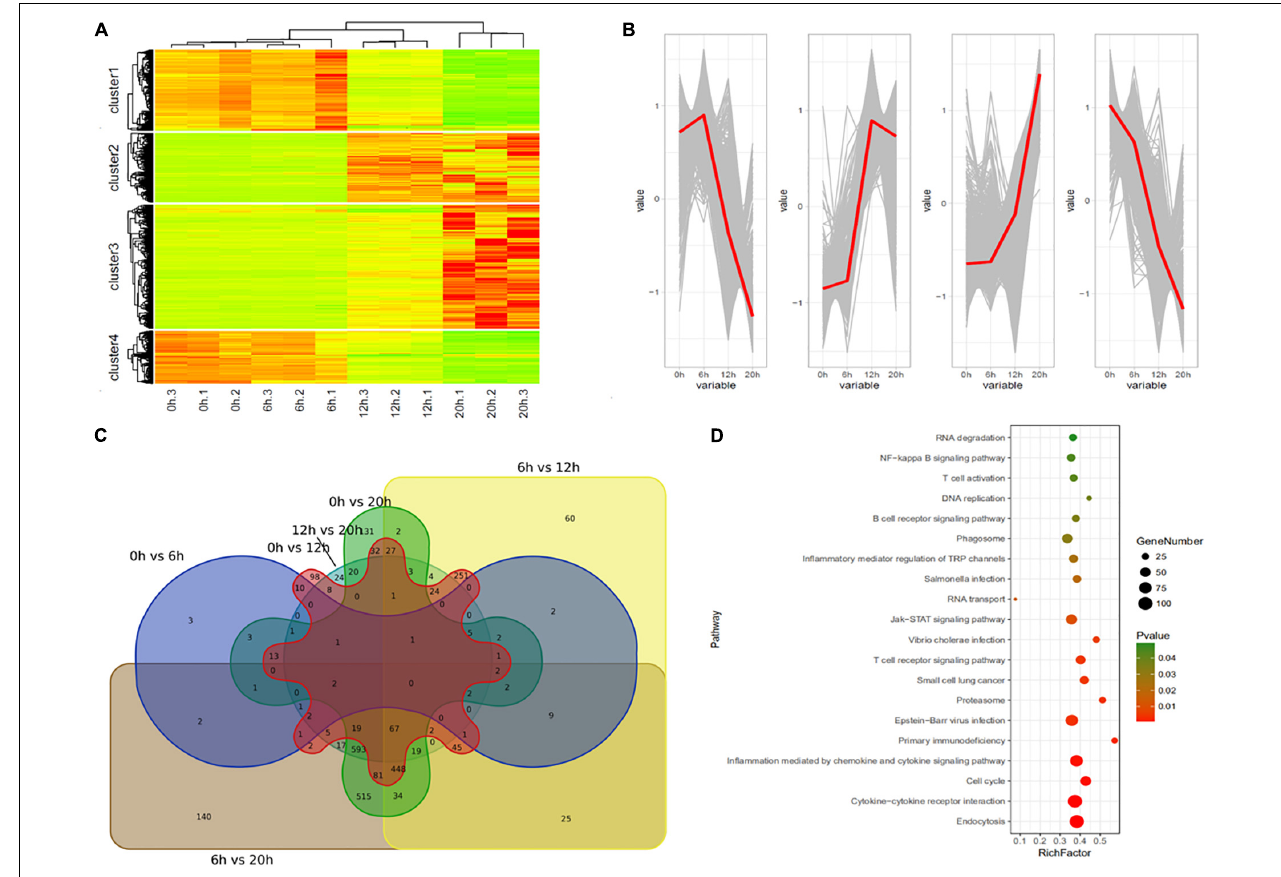
FIGURE 2 | Differentially expressed genes in H5N1-infected chicken DF1 cells. (A) Clustering analysis of differential gene expression patterns at 0, 6, 12, and 20 hpi. (B) The trends in differential gene expression patterns at 0, 6, 12, and 20 hpi. (C) Venn diagrams of overlapping DEGs between different time points. (D) Pathway enrichment analysis of the